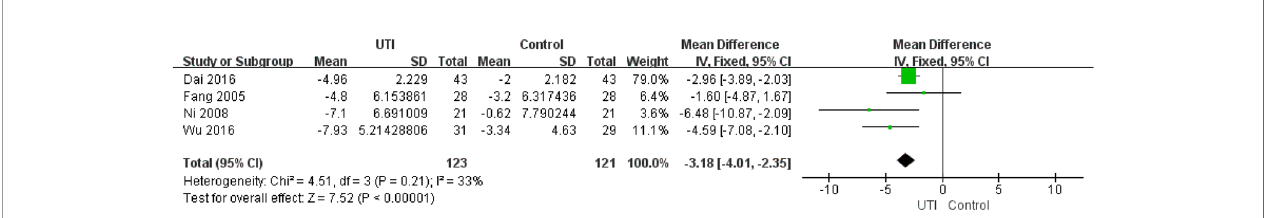
FIGURE 4 | Ulinastatin reduces the APACHE II score of sepsis